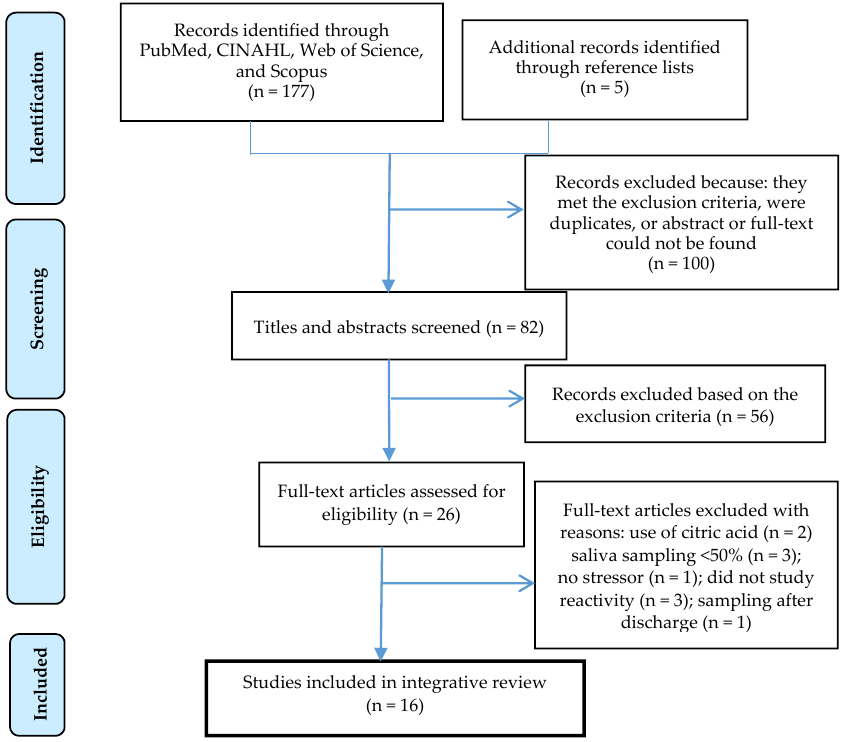
Figure 1. PRISMA flow diagram on the outcomes of the search strategies.